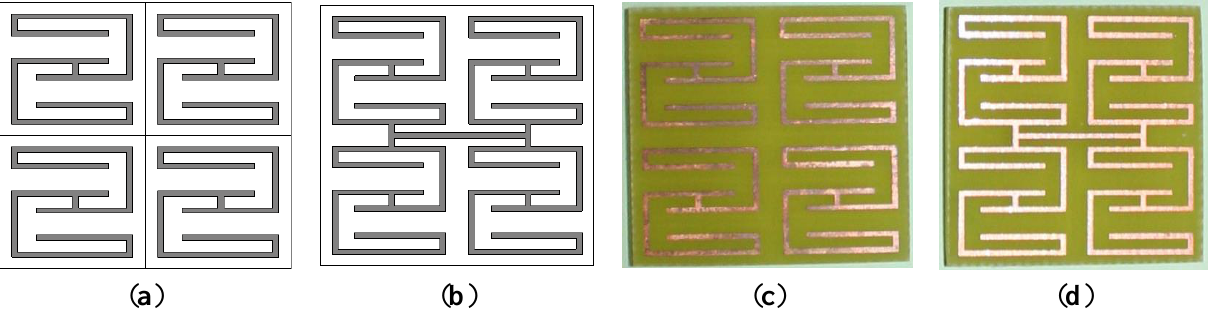
Figure 5. 2 × 2 array configuration of unit cells: ( a ) open array structure; ( b ) interconnected array structure; ( c ) prototype of an open array; and ( d ) prototype of an interconnected